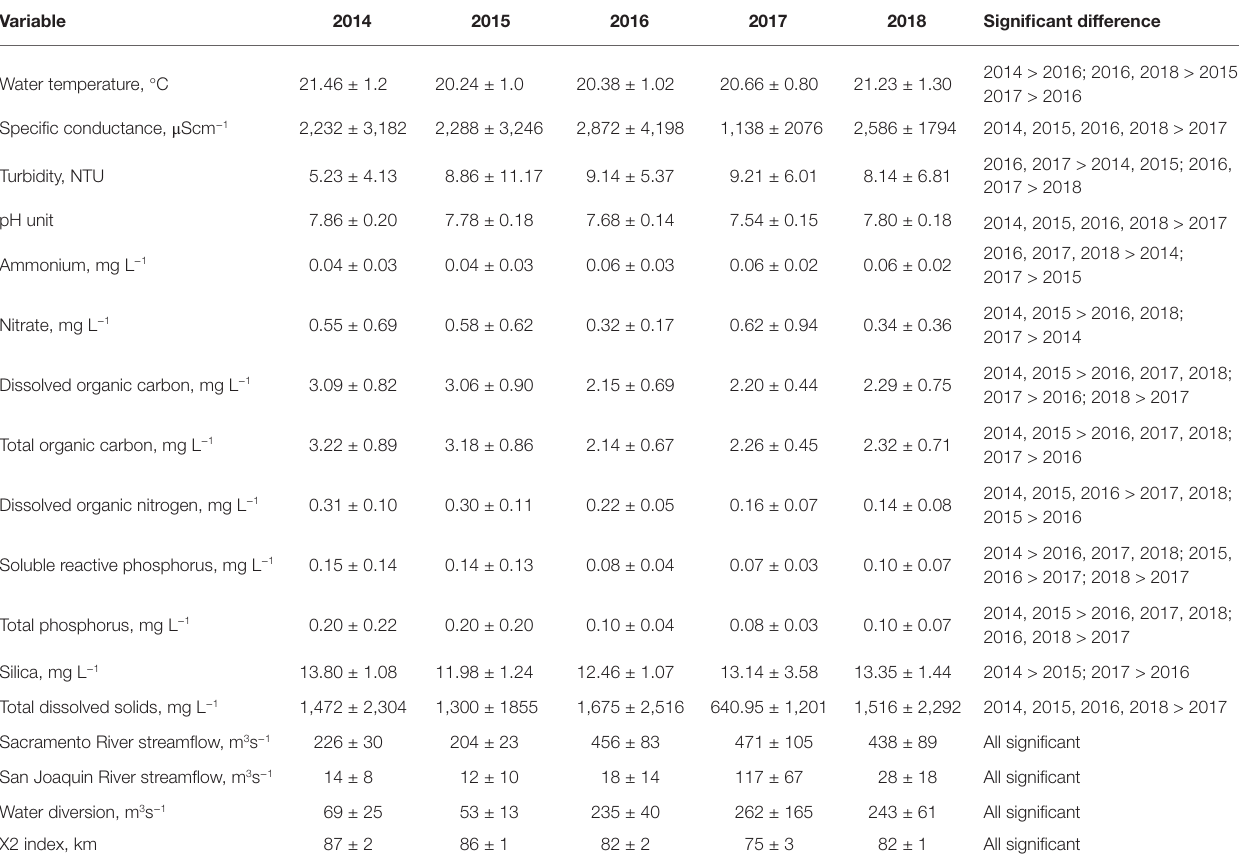
TABLE 1 | Average and SD of environmental variables measured at 10 stations between July and November for 2014–2018 in the